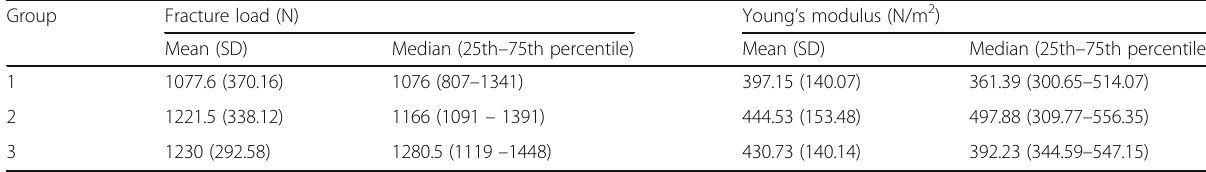
Table 3 Fracture load and Young ’ s modulus across experimental groups